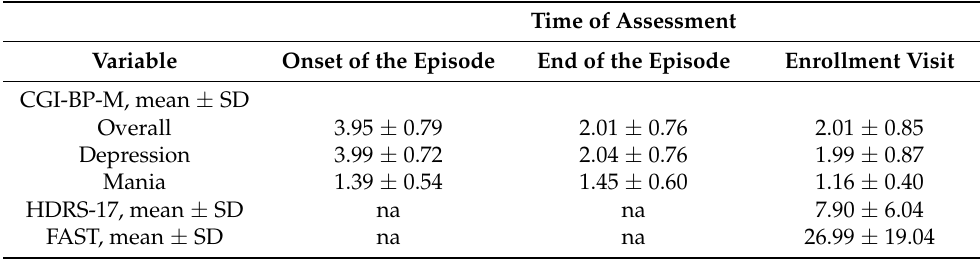
Table 2. Clinical assessment of the study population.